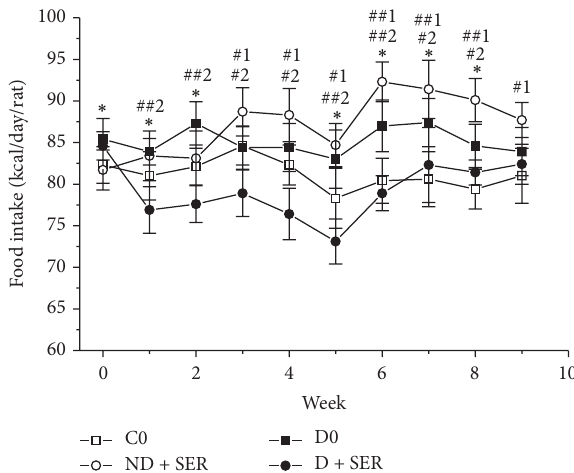
Figure 3: The influence of two-month treatment with intranasally administered serotonin on food intake in diabetic and nondiabetic rats. The data are presented as M ± SD. ( ∗ ) The difference between Groups C0 and D0 is significant at 𝑃 < 0 . 05, and (#, ##) the difference between Groups C0 and ND + SER (1) or between Groups D0 and D + SER (2) is significant at 𝑃 < 0 . 05 and 𝑃 < 0 . 0001, respectively.